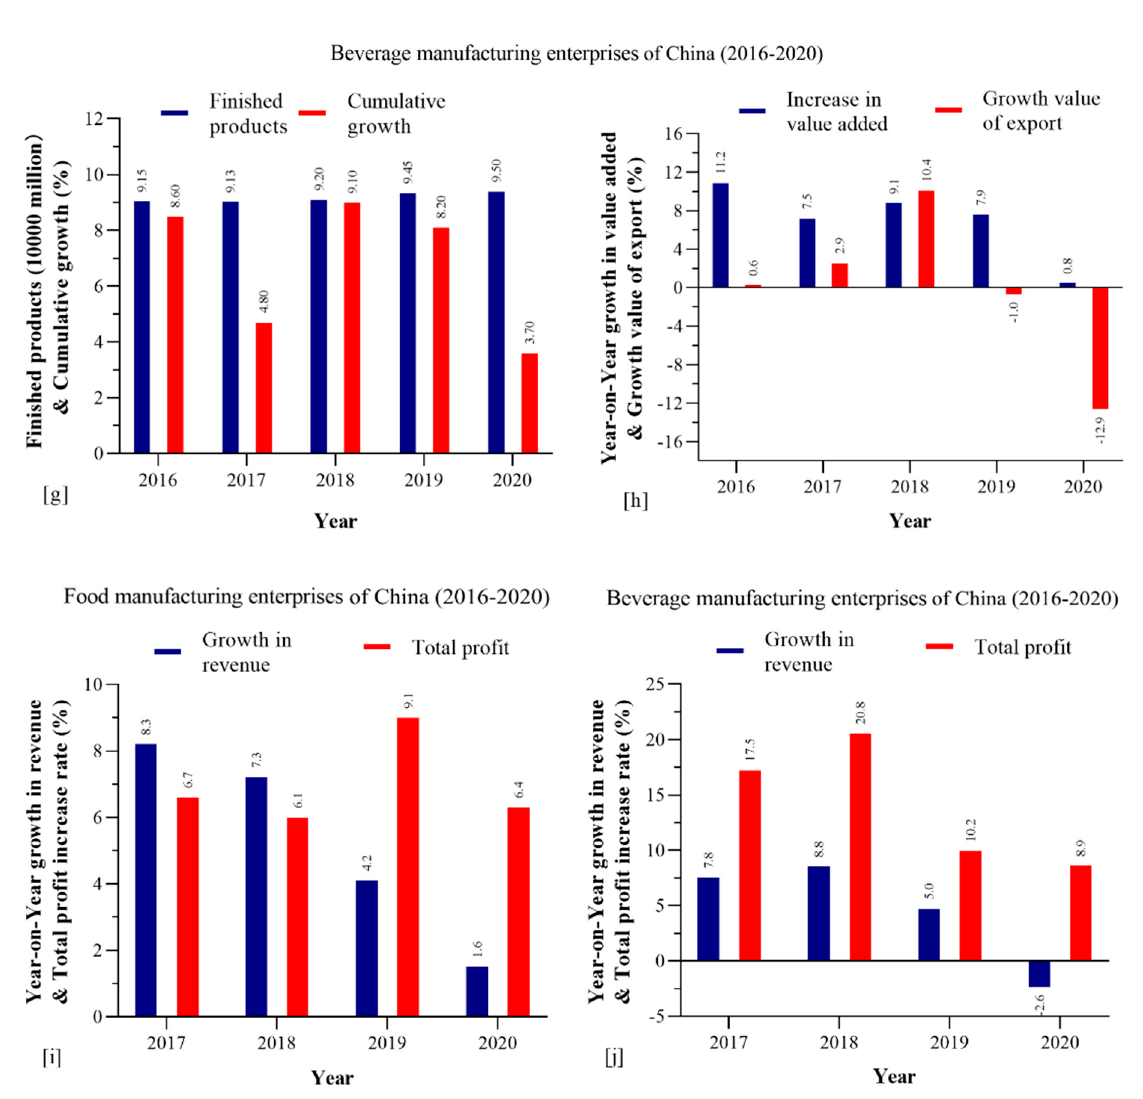
Figure 4. ( a ) Food manufacturing enterprises and loss-making enterprises in China. ( b ) Loss and cumulative growth (%). ( c ) Finished products and cumulative growth (%). ( d ) Year-on-year growth in value added and growth in value of export (%). ( e ) Beverage manufacturing enterprises and loss-making enterprises in China. ( f ) Loss and cumulative growth (%). ( g ) Finished products and cumulative growth (%). ( h ) Year-on-year growth in value added and growth in value of export (%). ( i ) Food and beverage manufacturing year-on-year growth in revenue and ( j ) total profit increase rate (%).